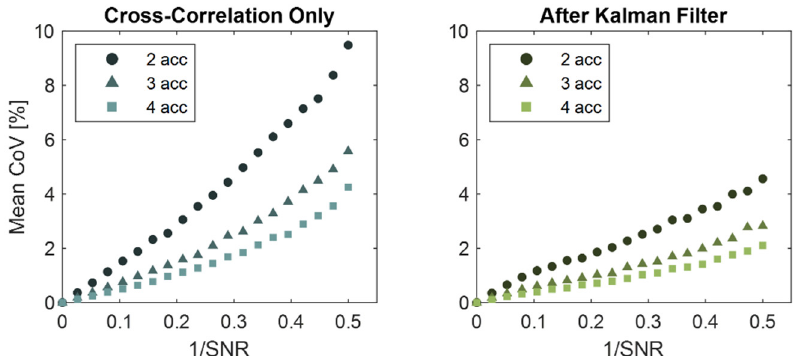
Figure 7. Both the Kalman filter and the use of additional accelerometers reduced errors in wave speed estimates for signal-to-noise ratios (SNR) tested. Plotted is the mean coefficient of variation (CoV—standard deviation of error normalized to prescribed wave speed) for simulated tensiometer data over a walking gait cycle. SNR represents the signal to noise ratio of the simulated accelerometer signals.